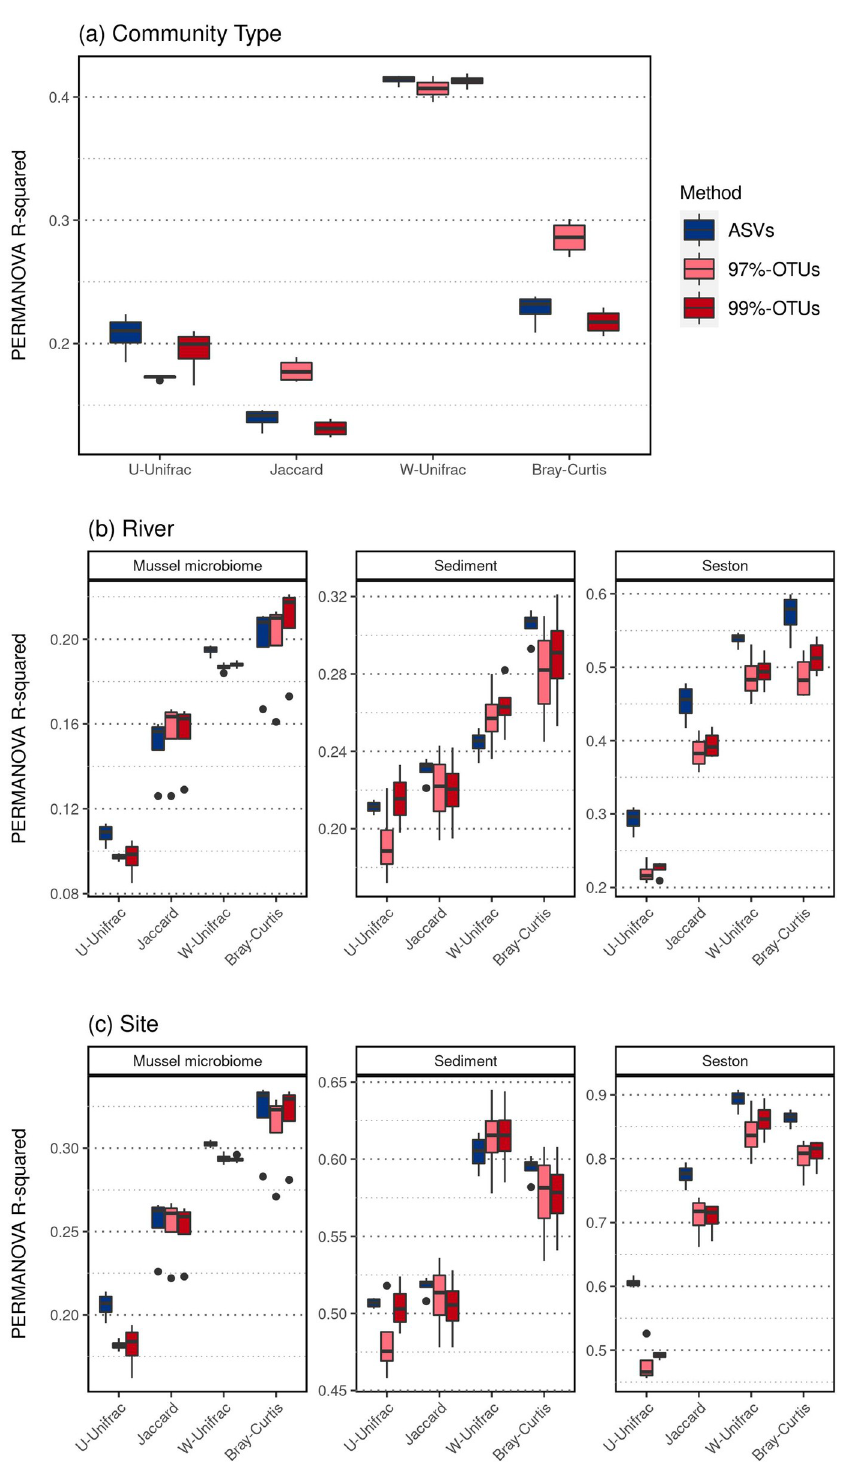
Fig 4. Effect of sequence processing on the ecological signal based on beta-diversity estimates in microbial communities. The intensity of the effect of (a) community type, (b) sampling river, and (c) collection site on community structure was assessed using separated PERMANOVAs for each factor, and each combination of sequence processing method x rarefaction level x index of dissimilarity. All rarefaction levels are aggregated on this figure. Differences across rarefaction levels are reported in S7 Fig in S1